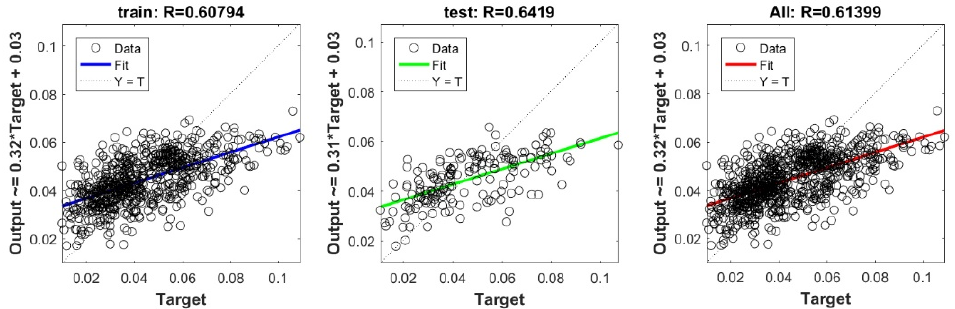
Figure A12. Scatter plots between target and output value by the GT-ELM model.